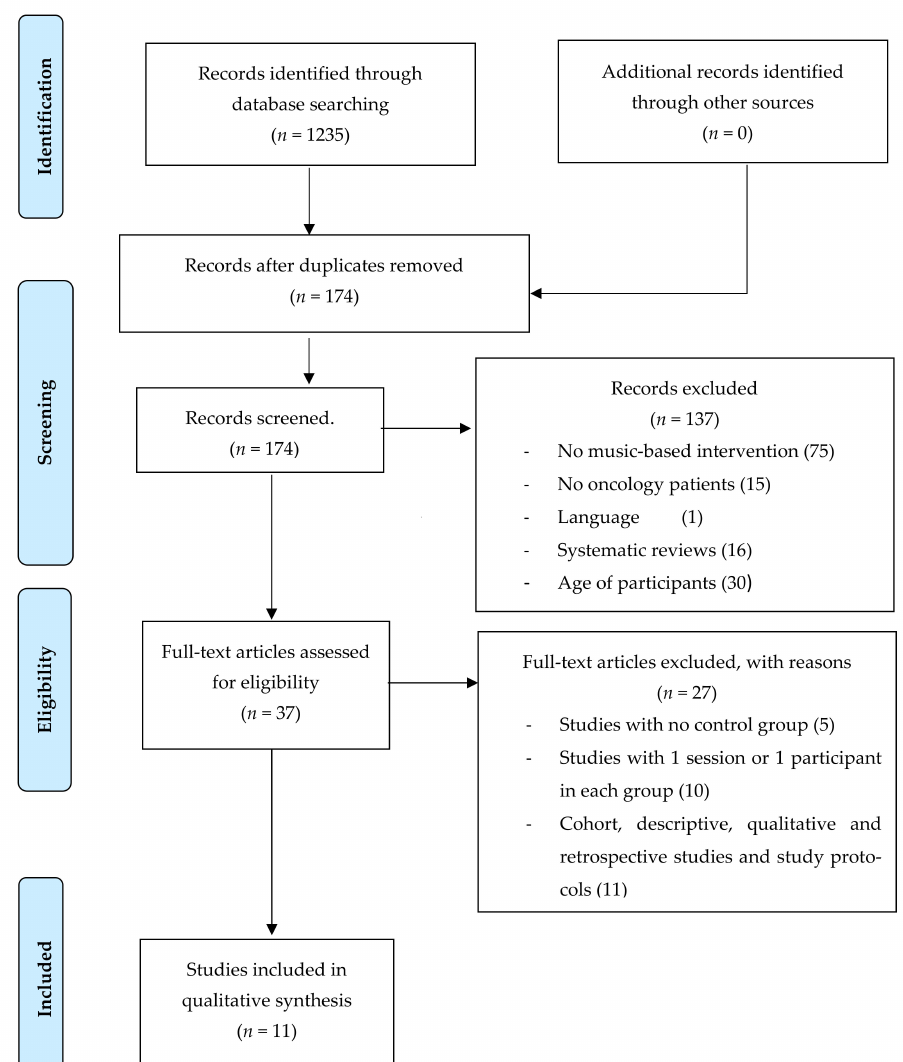
Figure 1. PRISMA